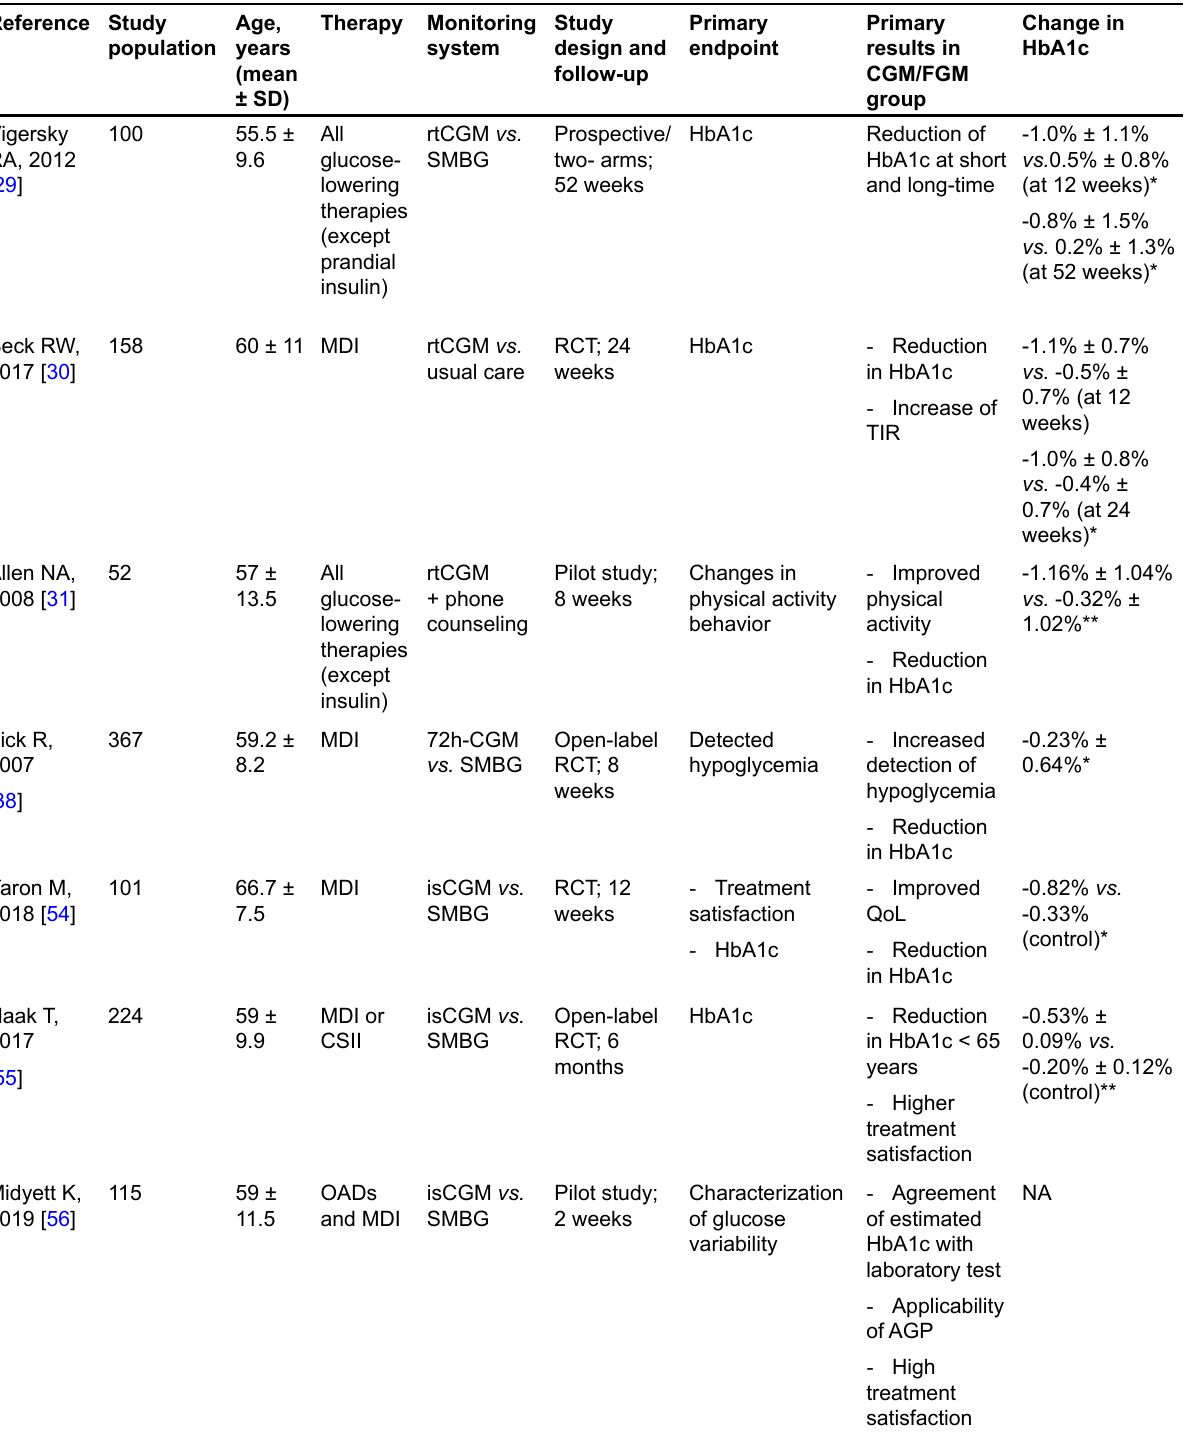
Table 2. Effects of CGM/isCGM among people with type 2 diabetes Reference